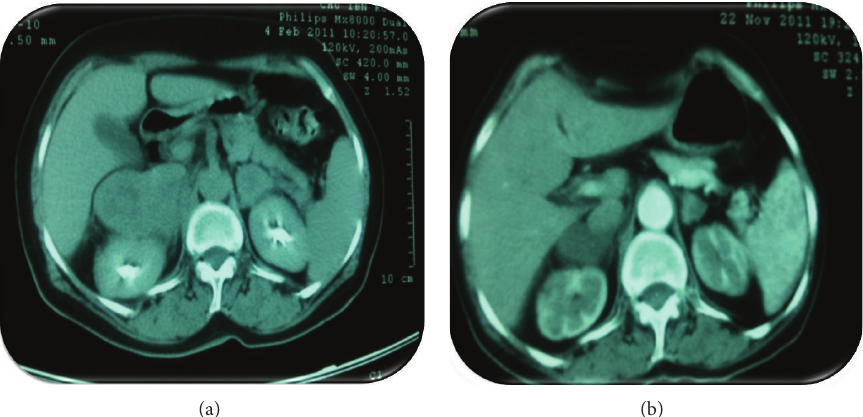
Figure 1: (a) Computed tomography of the abdomen shows a bilateral adrenal mass. (b) CT evaluation showed response of the adrenal metastases after chemotherapy.